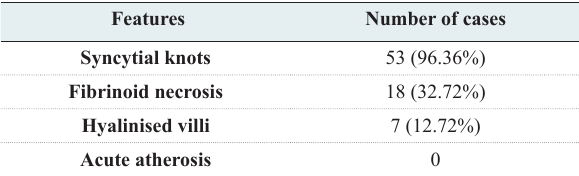
Table 3: Villous Pathology